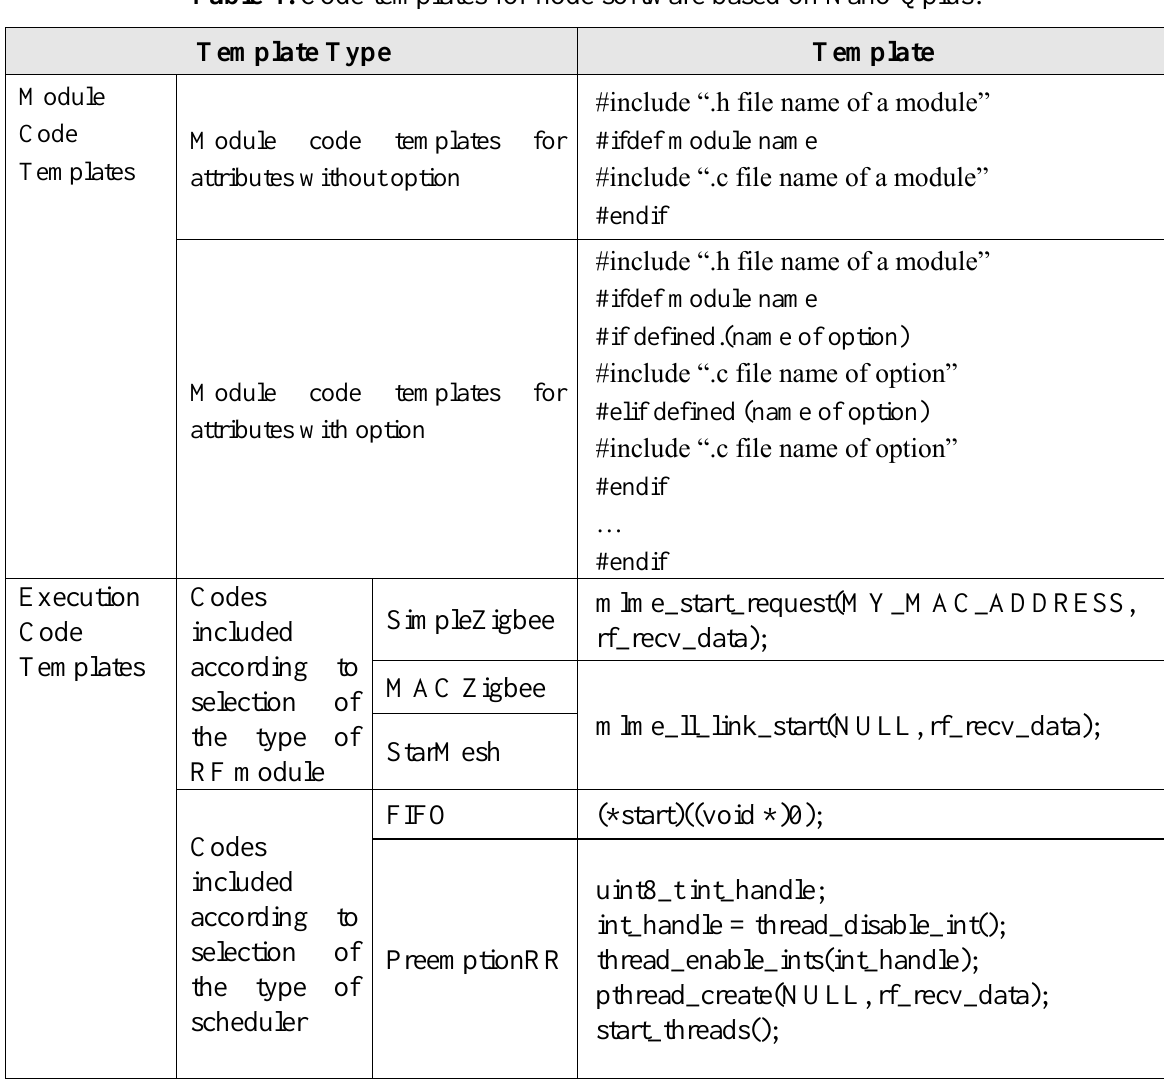
Table 4. Code templates for node software based on Nano-Qplus.